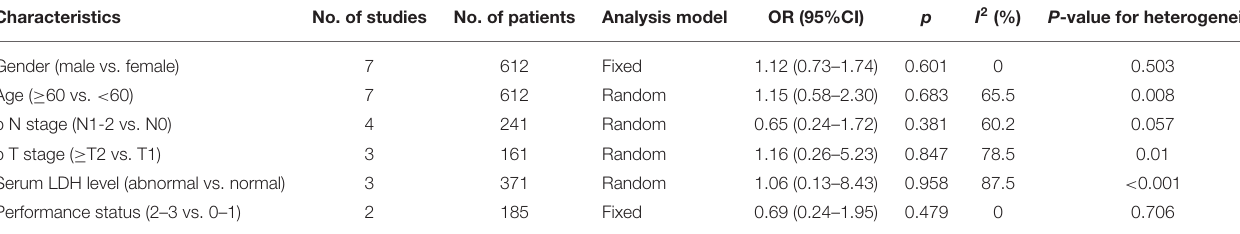
TABLE 4 | Meta-analysis of the association between PD-L1 expression and clinicopathological features of SCLC. Characteristics